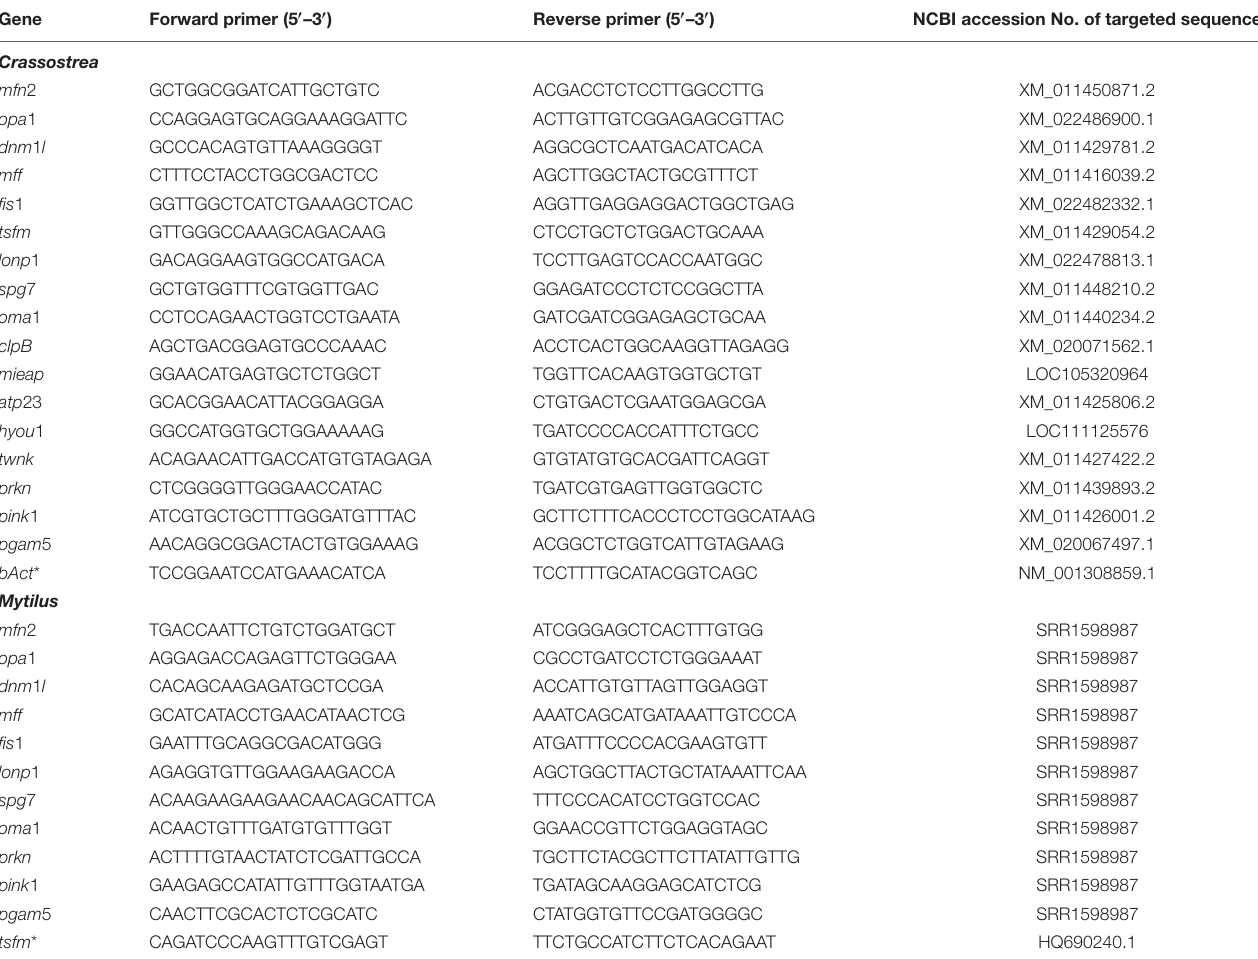
TABLE 1 | Primers used for qRT-PCR for genes of mitochondrial quality control in C. gigas and M. edulis . Gene Forward primer (5 (cid:48) –3 (cid:48) ) Reverse primer (5 (cid:48) –3 (cid:48) ) NCBI accession No. of targeted